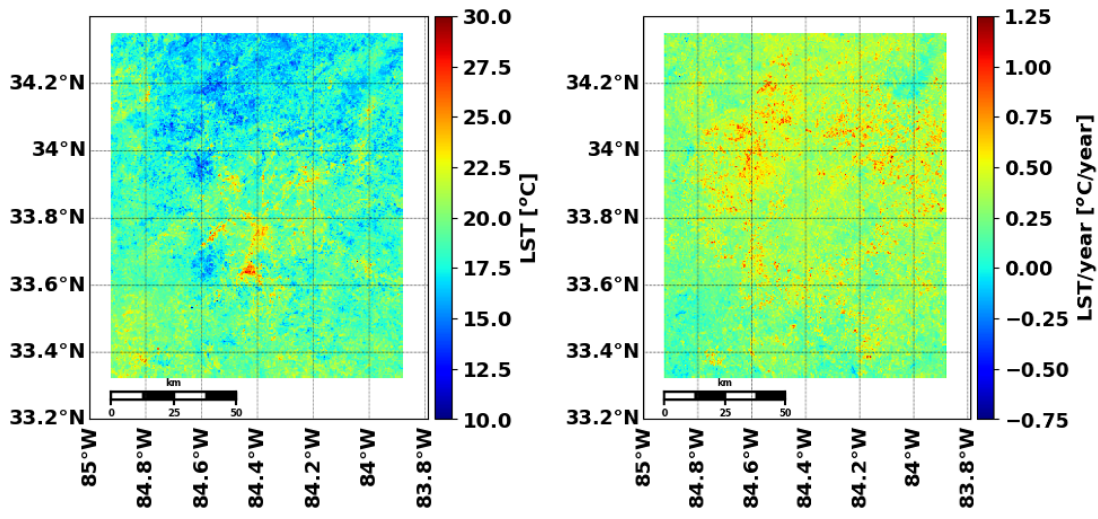
Figure 4. Constant (left panel) and rate (right panel) parameters of the LST linear model of Equation (1) for the Atlanta MA (pixel size of 300